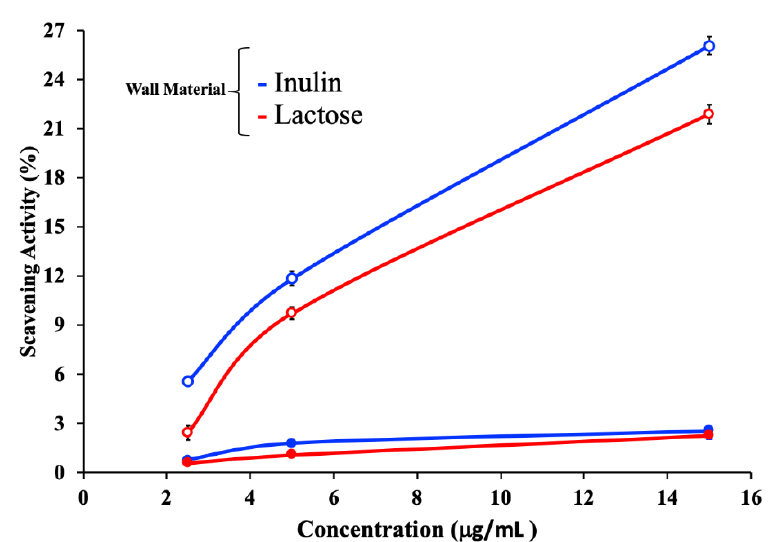
Figure 2. Effect of inulin and lactose matrices on the scavenging activity of microencapsulated B. clausii (BcL and BcIN) closed circles; and resveratrol (LRSV and INRSV) open circles.